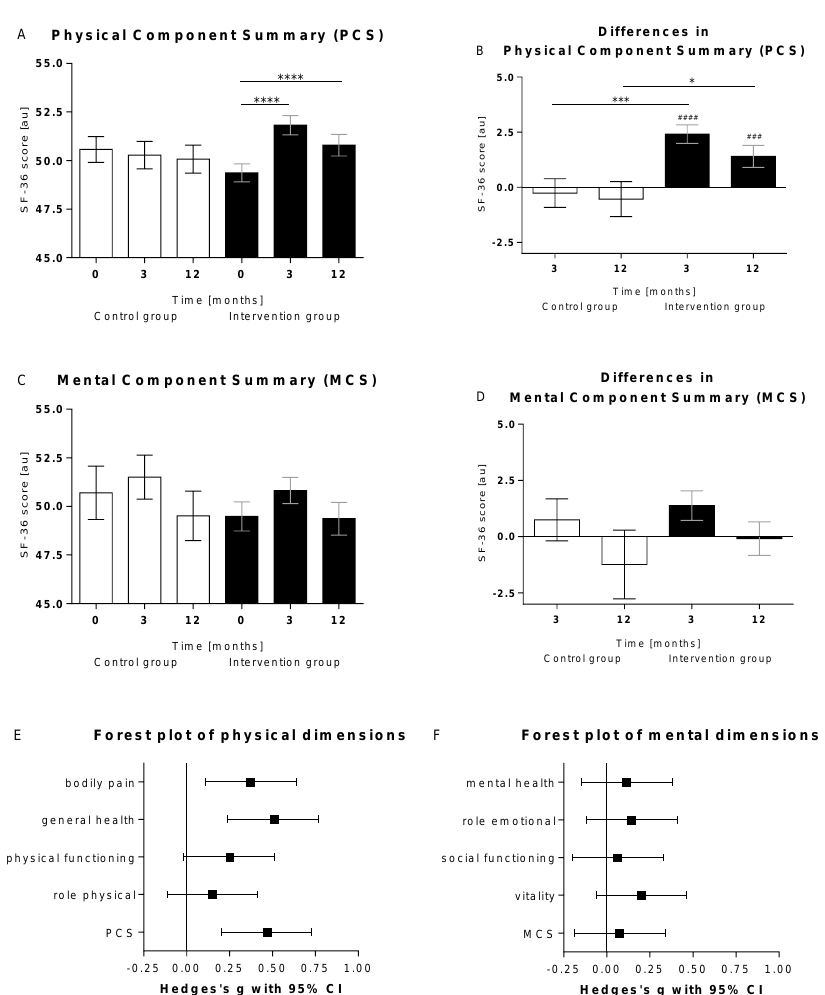
Figure 3. Physical and mental component summary. Shown are ( A ) absolute and ( B ) ∆ values of the physical component score (PCS) in the control ( n = 80) and the intervention ( n = 183) group at baseline as well as after 3 months of intervention and after 12 months (=6 months after end of intervention). ( C ) shows absolute and ( D ) ∆ values of the mental component score (MCS). Data were analysed with the Friedman test and with Dunn’s multiple comparison test (****, p < 0.0001). Within- group differences were compared using the Wilcoxon signed-rank test ( ### , p < 0.001; #### , p < 0.0001) and between group differences using the Mann–Whitney test (*, p < 0.05; ***, p < 0.001). Data are shown as mean ± standard error of means. au, arbitrary units. Forest plot of ( E ) physical and ( F ) mental dimensions. Black squares symbolise the Hedges’s g point estimate of the effect size and the horizontal lines represent the 95% confidence intervals